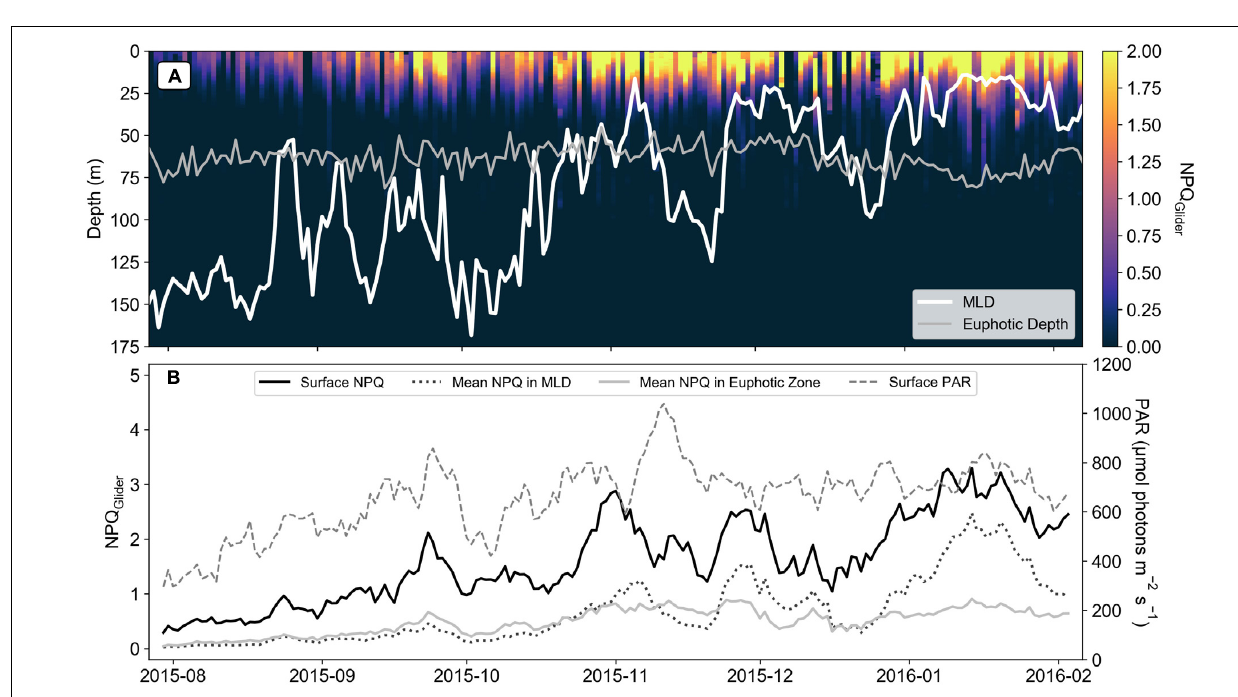
FIGURE 4 | (A) Section of glider derived NPQ (NPQ Glider ), with the daily mean mixed layer depth (MLD) and euphotic depth ( n = 195). (B) A 7-day rolling mean of Surface NPQ Glider , mean NPQ Glider in MLD, mean NPQ Glider in the euphotic zone and surface PAR ( µ mol photons m - 2 s - 1 ) for the glider time